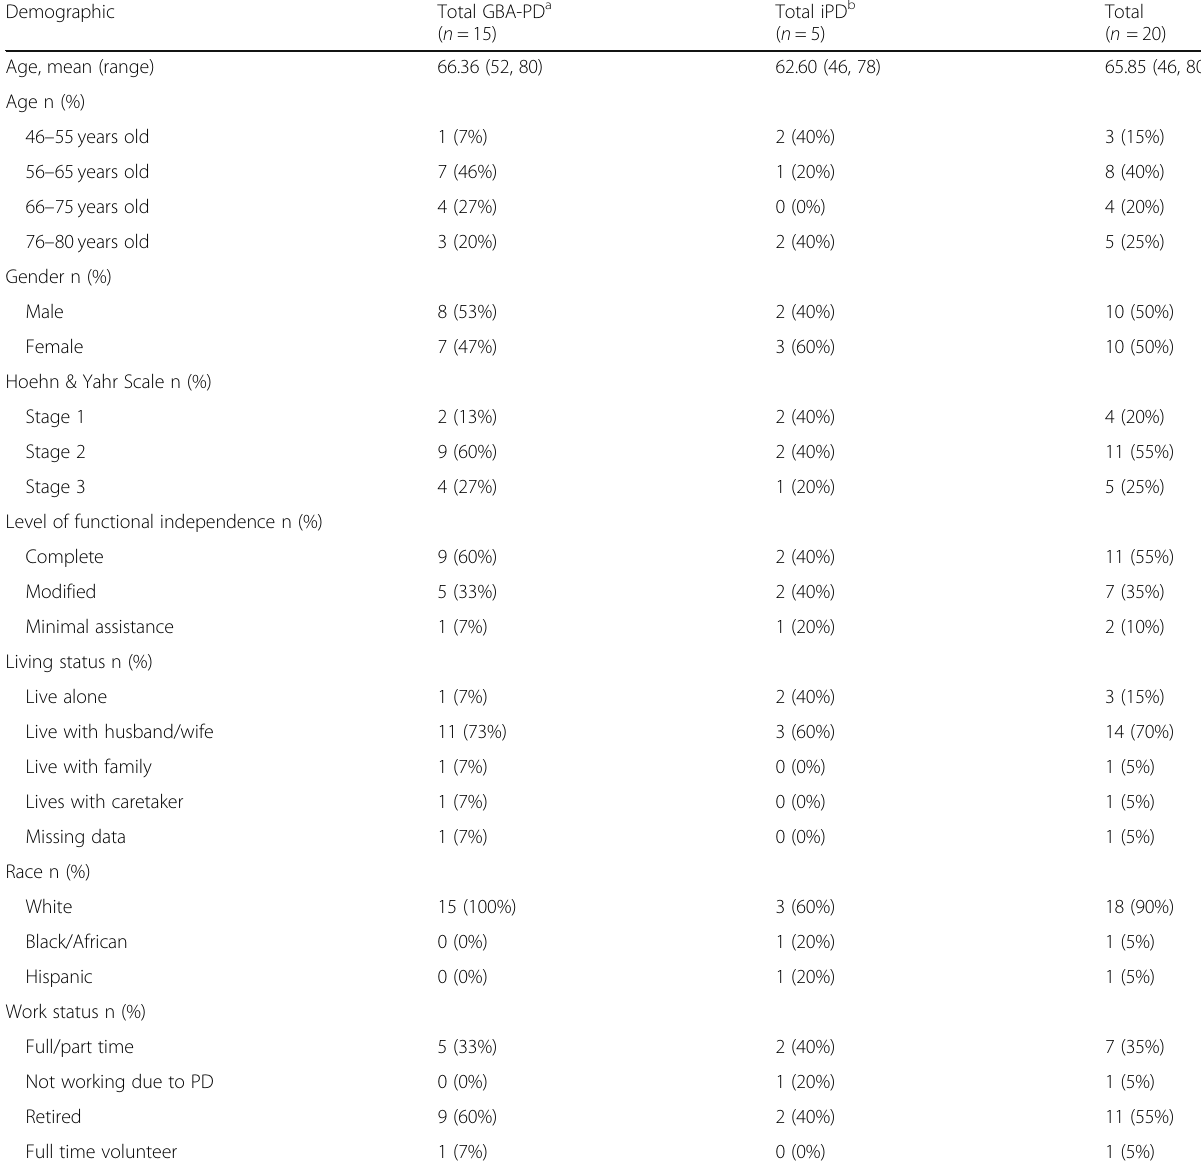
Table 2 Demographic and clinical characteristics of GBA-PD a and iPD b patient samples